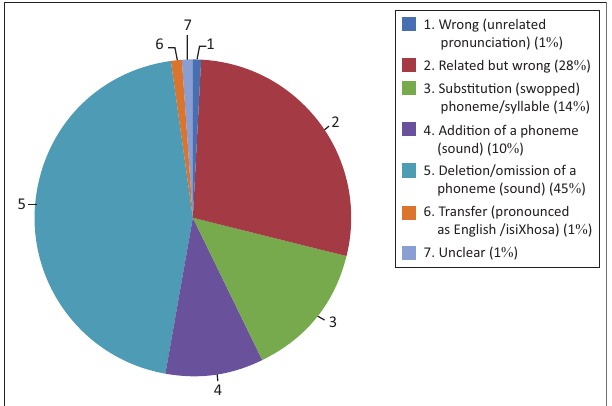
FIGURE 6: School X English Pseudo-words ( n = 114). Mixed strategies (lexical and